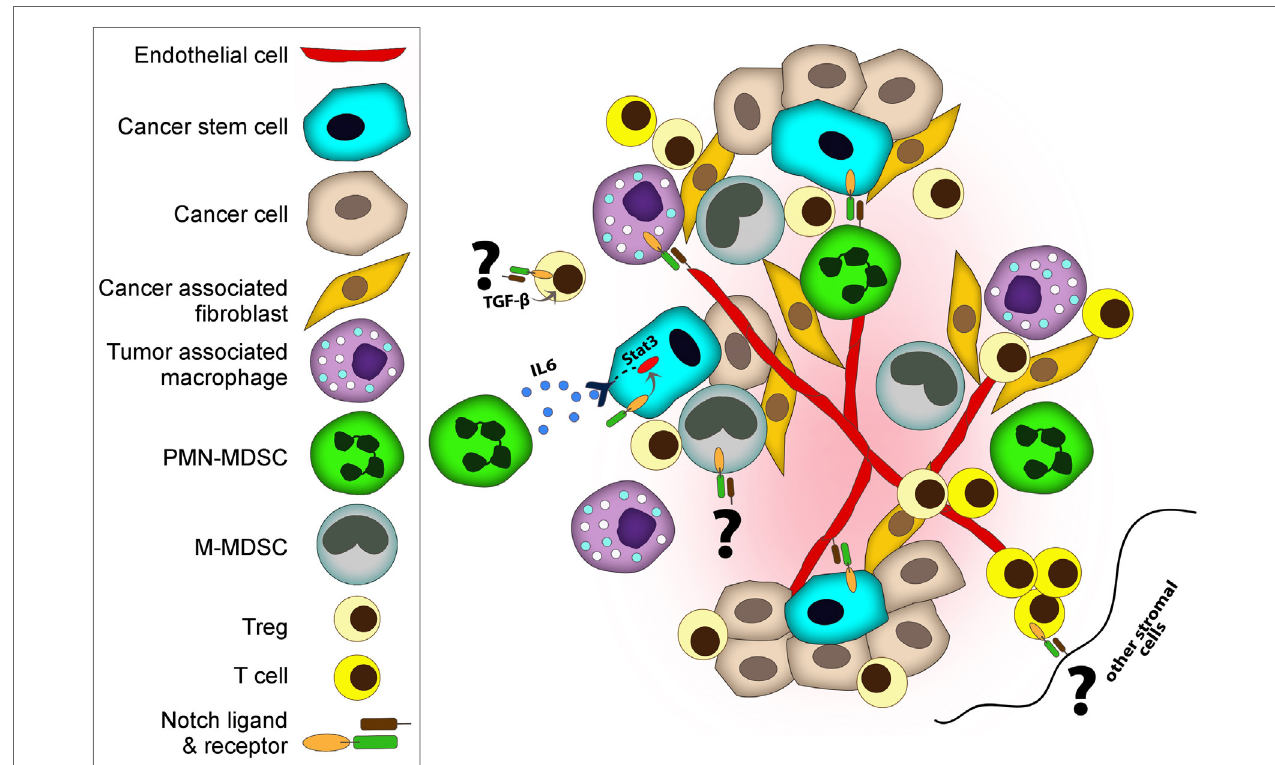
FigURe 2 | Notch regulates both cancer cells and cancer stem cells (CSCs) and many components of tumor microenvironment including immune cells, fibroblasts, and endothelial. Notch co-operates with various key signaling pathways to exert its functions. Tumor-associated macrophages and myeloid-derived suppressor cells (MDSCs) promote tumor progression by various mechanisms including suppressing immune cells, supporting CSC, and enhancing angiogenesis and metastasis. (i) Deregulated Notch activity in MDSC results in expansion of M-MDSC. (i and ii) MDSCs induce Notch signaling in cancer cells and promote CSC capacity. (iii) MDSCs can also promote CSCs through IL-6/STAT3 activation and nitric oxide/Notch cross-talk signaling. Notch helps sustain STAT3 signaling which is important for CSC maintenance. (iv) Similar to MDSCs, regulatory T cells (Tregs) also promote evasion of immune surveillance. Notch-1–TGF- β signaling cooperatively regulates Foxp3 gene expression, and hence directly induces peripheral Tregs. (v) On the other hand, DLL-1 expressing dendritic cells or stromal cells can activate Notch in cytolytic T cells and enhance antitumor activities. (vi) Moreover, endothelial cells contribute to tumor progression and metastasis. Notch1 controls macrophage recruitment to endothelial cells and facilitate vessel branching, which can increase metastasis. (vii) In addition to facilitating the invasion of cancer cells, endothelial cells play a role as CSC niches by releasing supportive factors or by direct cellular